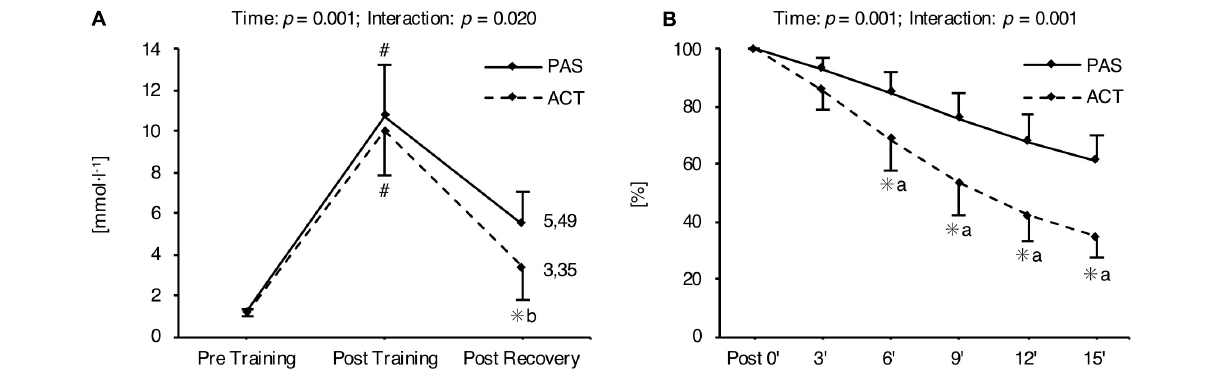
FIGURE 2 | Mean ( ± SD) blood lactate concentration throughout each HIIT session determined before (Pre Training) and after training (Post Training), as well as after recovery (Post Recovery) (A) . Mean ( ± SD) percentage blood lactate concentration relative to post-training concentration, measured 3, 6, 9, 12, and 15 min after the 10th HIIT session (B) . #Significant difference compared with Pre Training and Post Recovery ( p < 0.05); ∗ significant difference compared with passive recovery ( p < 0.05); a moderate effect size; b large effect size. ACT, active recovery; PAS, passive